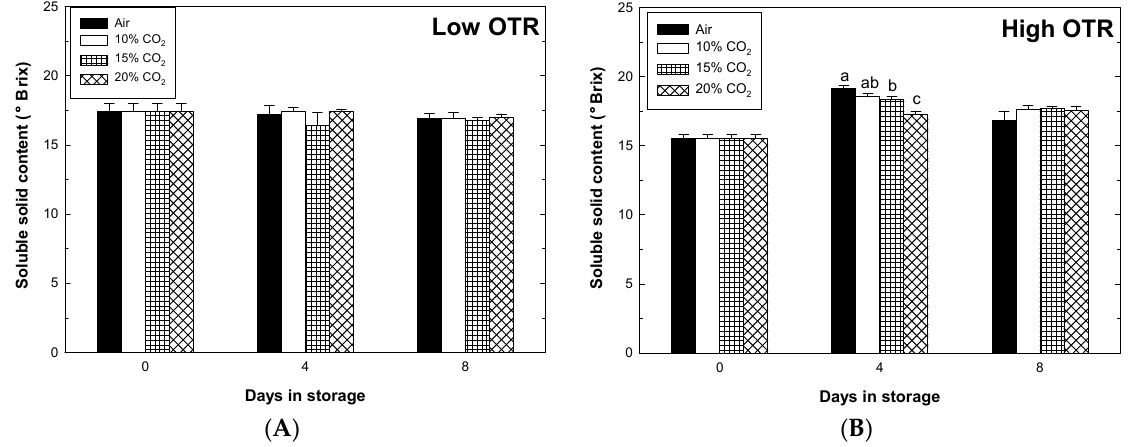
Figure 8. Soluble solid content of ‘Pione’ grapes stored in active MAP of high CO 2 (10%, 15%, and 20%) with low-OTR films ( A ) and high-OTR films ( B ) at 10 °C for 8 days. Vertical lines represent the standard error of the mean ( n = 9). Bars with different letters indicate significance at p ≤ 0.05 among treatments within the same day